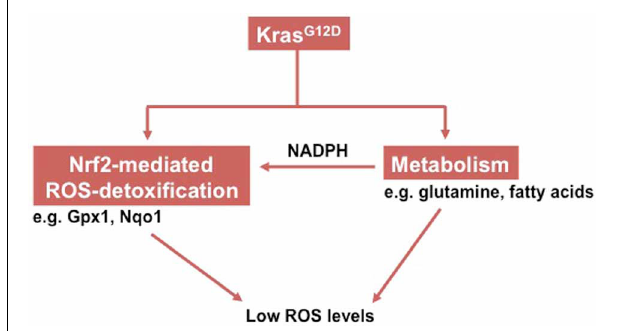
FIGURE 1 | Schema showing how oncogenic Kras induces low intracellular ROS